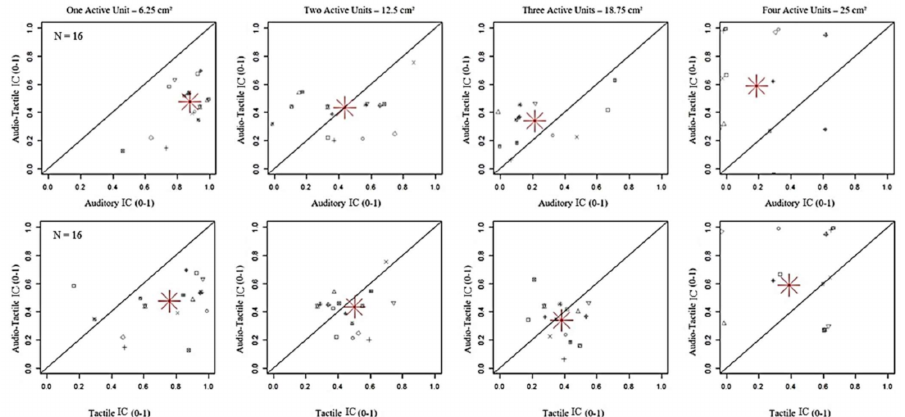
Figure 4. Comparison of index correct (IC) between bimodal Audio-Tactile stimuli and unimodal Auditory and Tactile stimuli. The grey symbols represent the values of index correct in the Audio- Tactile modality (y-axis), expressed as an index between 0 and 1, per participant. The red asterisk is the average on the total number of participants. IC was lower with bimodal than both unimodal stimulations when one unit was active (6.25 cm 2 ) ( p < 0.001), while it increased until 18.75 cm 2 with a significant difference with respect to Auditory ( p < 0.001) but not Tactile ( p = 1.00)